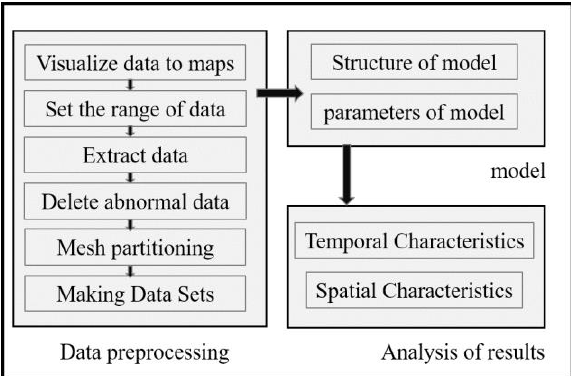
Figure 1. The experimental research